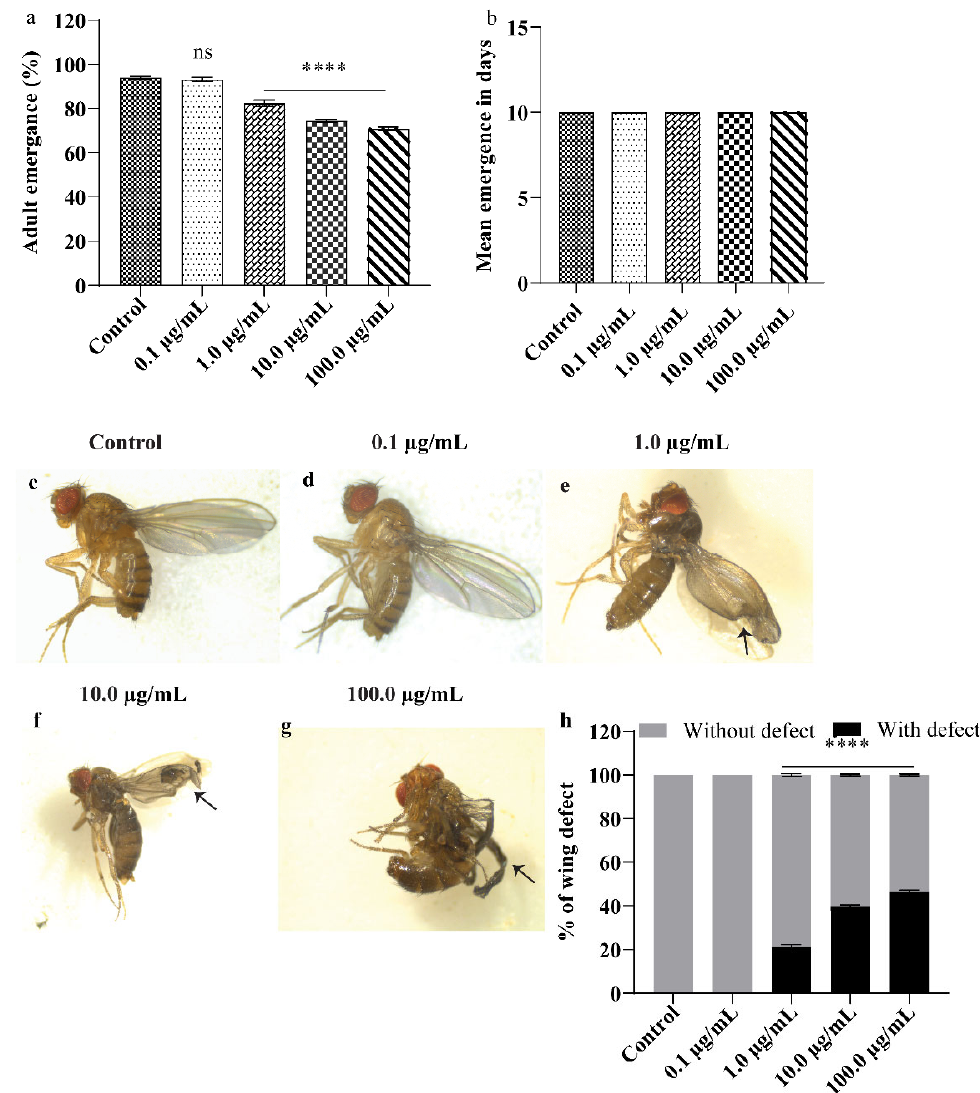
Figure 2. Developmental assay. ( a ) Total percentage of adult emergence in control and A.L. extract- treated groups ( b ) Mean emergence in days ( c – g ) representative image of flies with wing phenotypes with control and A.L. extract-treated flies ( h ) percentage of wing defect. Significance is ascribed as ns and **** p < 0.0001 compared to control.